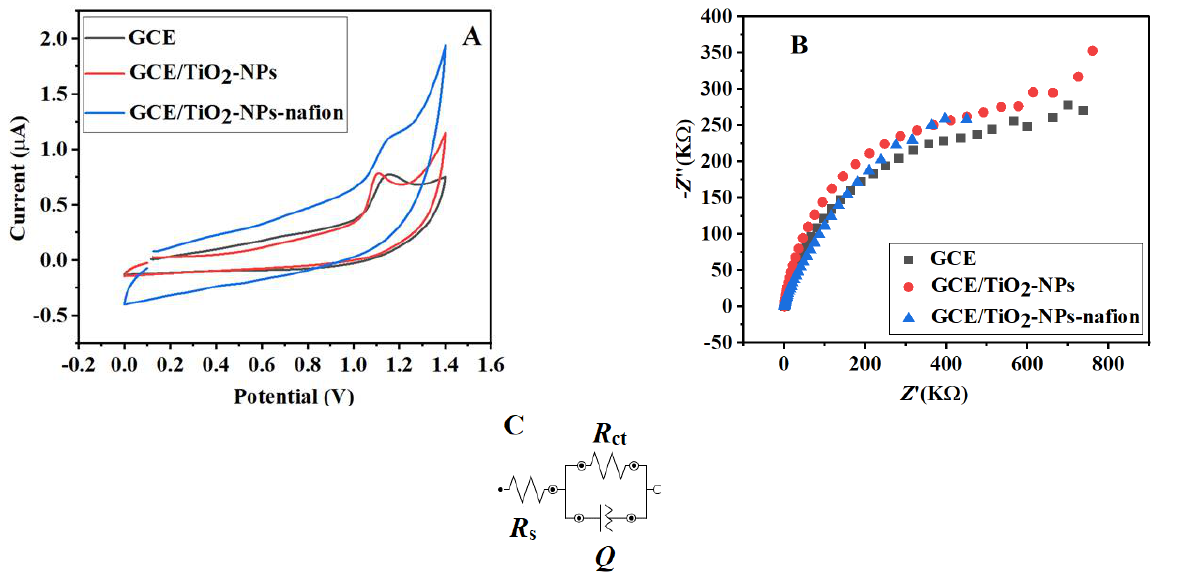
Figure 7. ( A ) CVs at 25 mV/s, ( B ) Nyquist plots obtained at the bare and modified GCEs in 0.1 M PBS at pH 7 containing 47.6 µM EFV, and ( C ) is the equivalent circuit-[R(RQ)] for the electrodes. Table 4. Impedance data obtained for electrodes in 47.6 µM EFV at a fixed potential of 1.2 V (vs. Ag/AgCl, standard KCl). The % errors of the data fitting are shown in parenthesis.